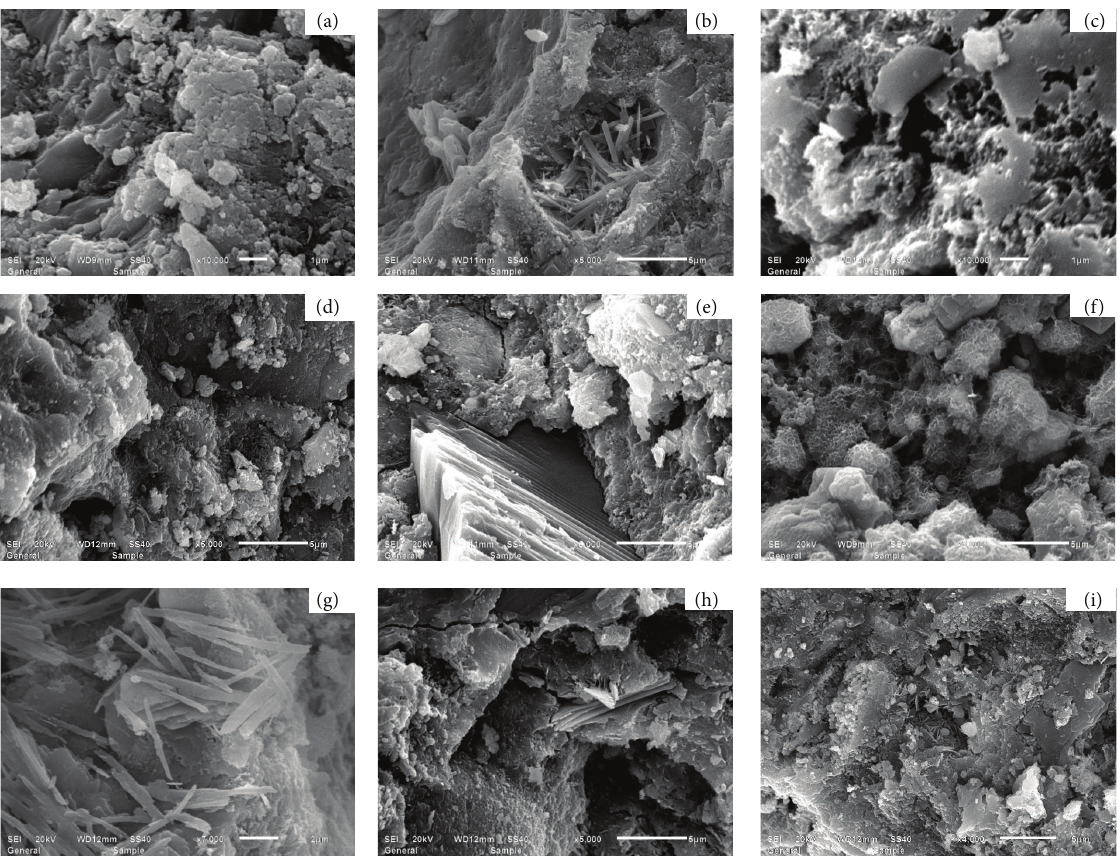
Figure 7: SEM images of samples (((a), (b), (c)) erosion in 5% sodium sulfate solution for 120 days; ((d), (e), (f)) two hundred times’ freeze- thaw; ((g), (h), (i)) four times’ erosion freeze-thaw